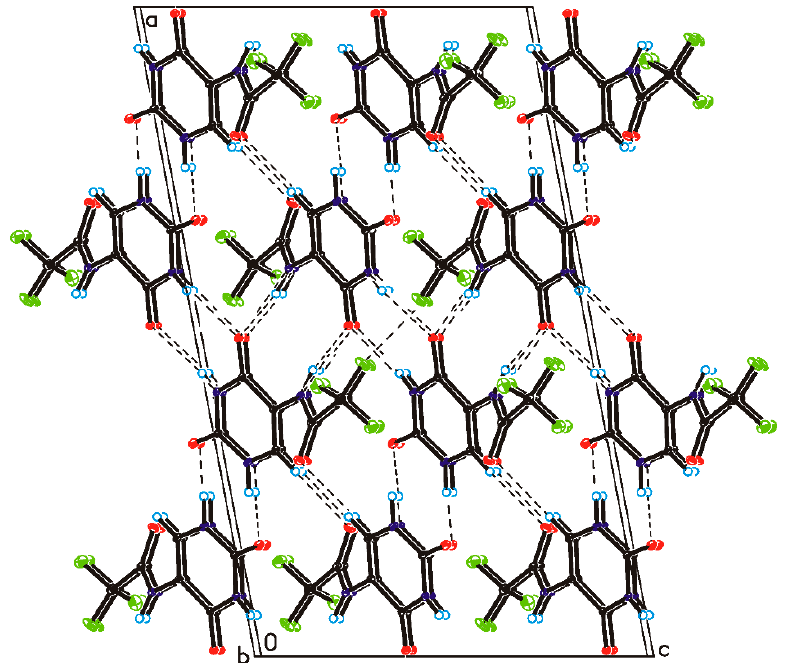
Figure 4. Crystal packing of 5-( N -trifluoromethylcarboxy) aminouracil viewed along the b -axis (hydrogen bonds are represented by dashed lines).